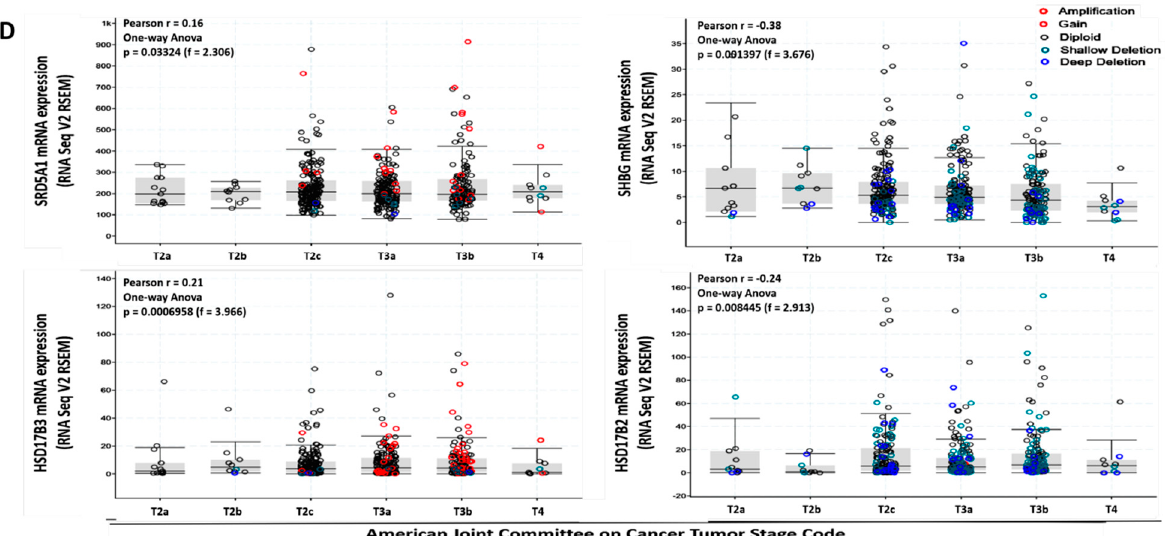
Figure 1. The aberrant expression of the testosterone metabolic tetrad HSD17B2, HSD17B3, SHBG, and SRD5A1 characterize androgen ‐ addicted PCa and is associated with disease progression. ( A ) Depiction of the gene ontology biological ‐ process ‐ based Fisher’s exact overrepresentation test using the GO Ontology database. ( B ) Histograms showing the differential expression of HSD17B2, HSD17B3, SHBG, or SRD5A1 mRNA in normal and primary tumor from the TCGA PRAD cohort. ( C ) Representative photo ‐ images and quantitative chart of the expression of HSD17B2, HSD17B3, SHBG, or SRD5A1 protein in normal prostate, low ‐ grade, or high ‐ grade samples from the SHH PCa cohort. ( D ) Box and whisker plots showing the differential expression of SRD5A1, SHBG, HSD17B2, or HSD17B3 mRNA according to the AJCC tumor stage. FDR, false discovery rate; F.C, fold change; SHH, Shuang Ho Hospital; AJCC, American Joint Committee on Cancer.